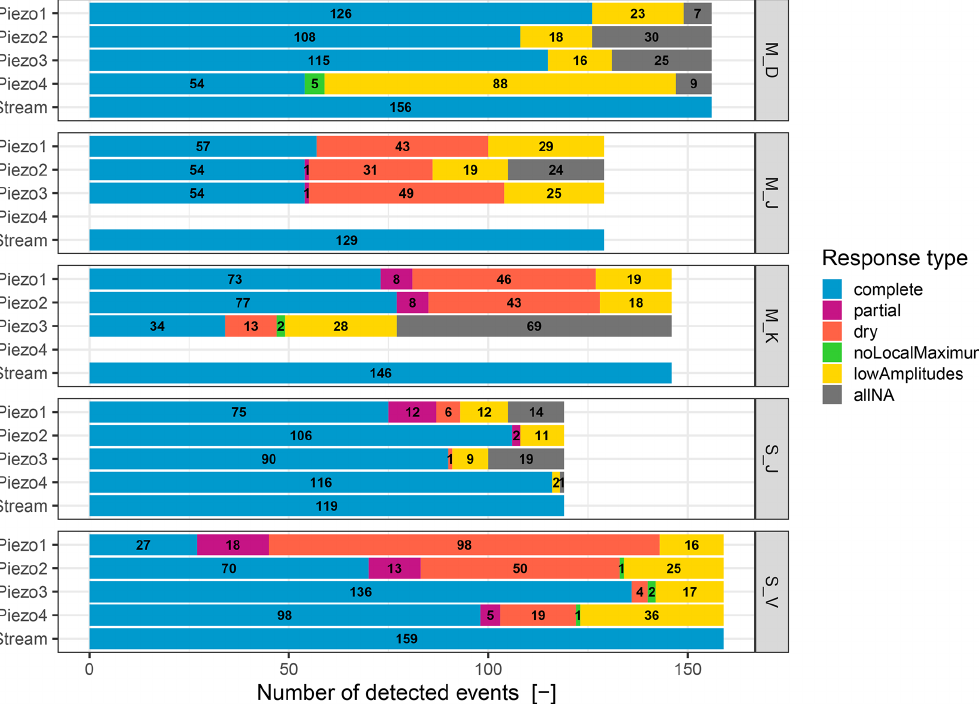
Figure 7. Number of detected events in the streams and groundwater at each stream gauge and piezometer, including types of event